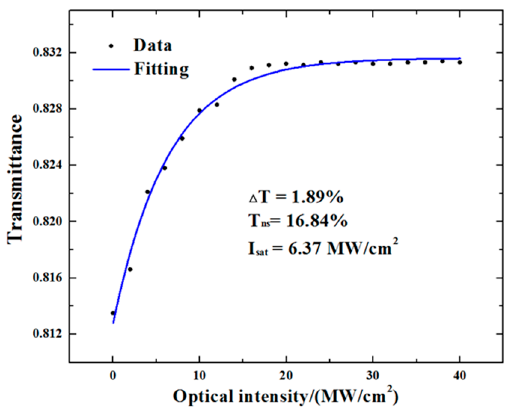
Figure 3. Nonlinear saturable absorption curve of the few-layer ReSe 2 SA.